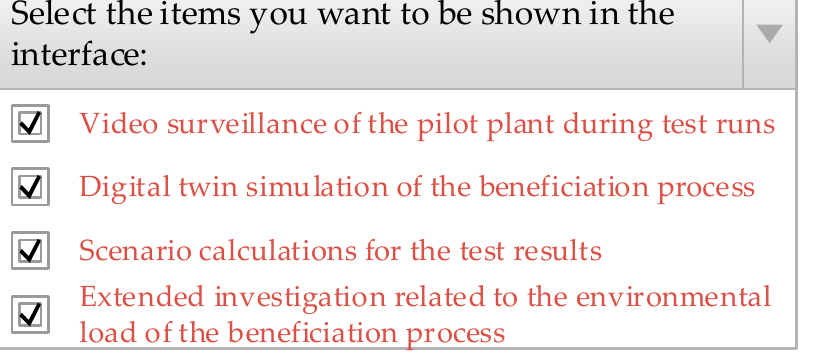
Figure 13. List of the services provided by GTK Mintec for the customers.